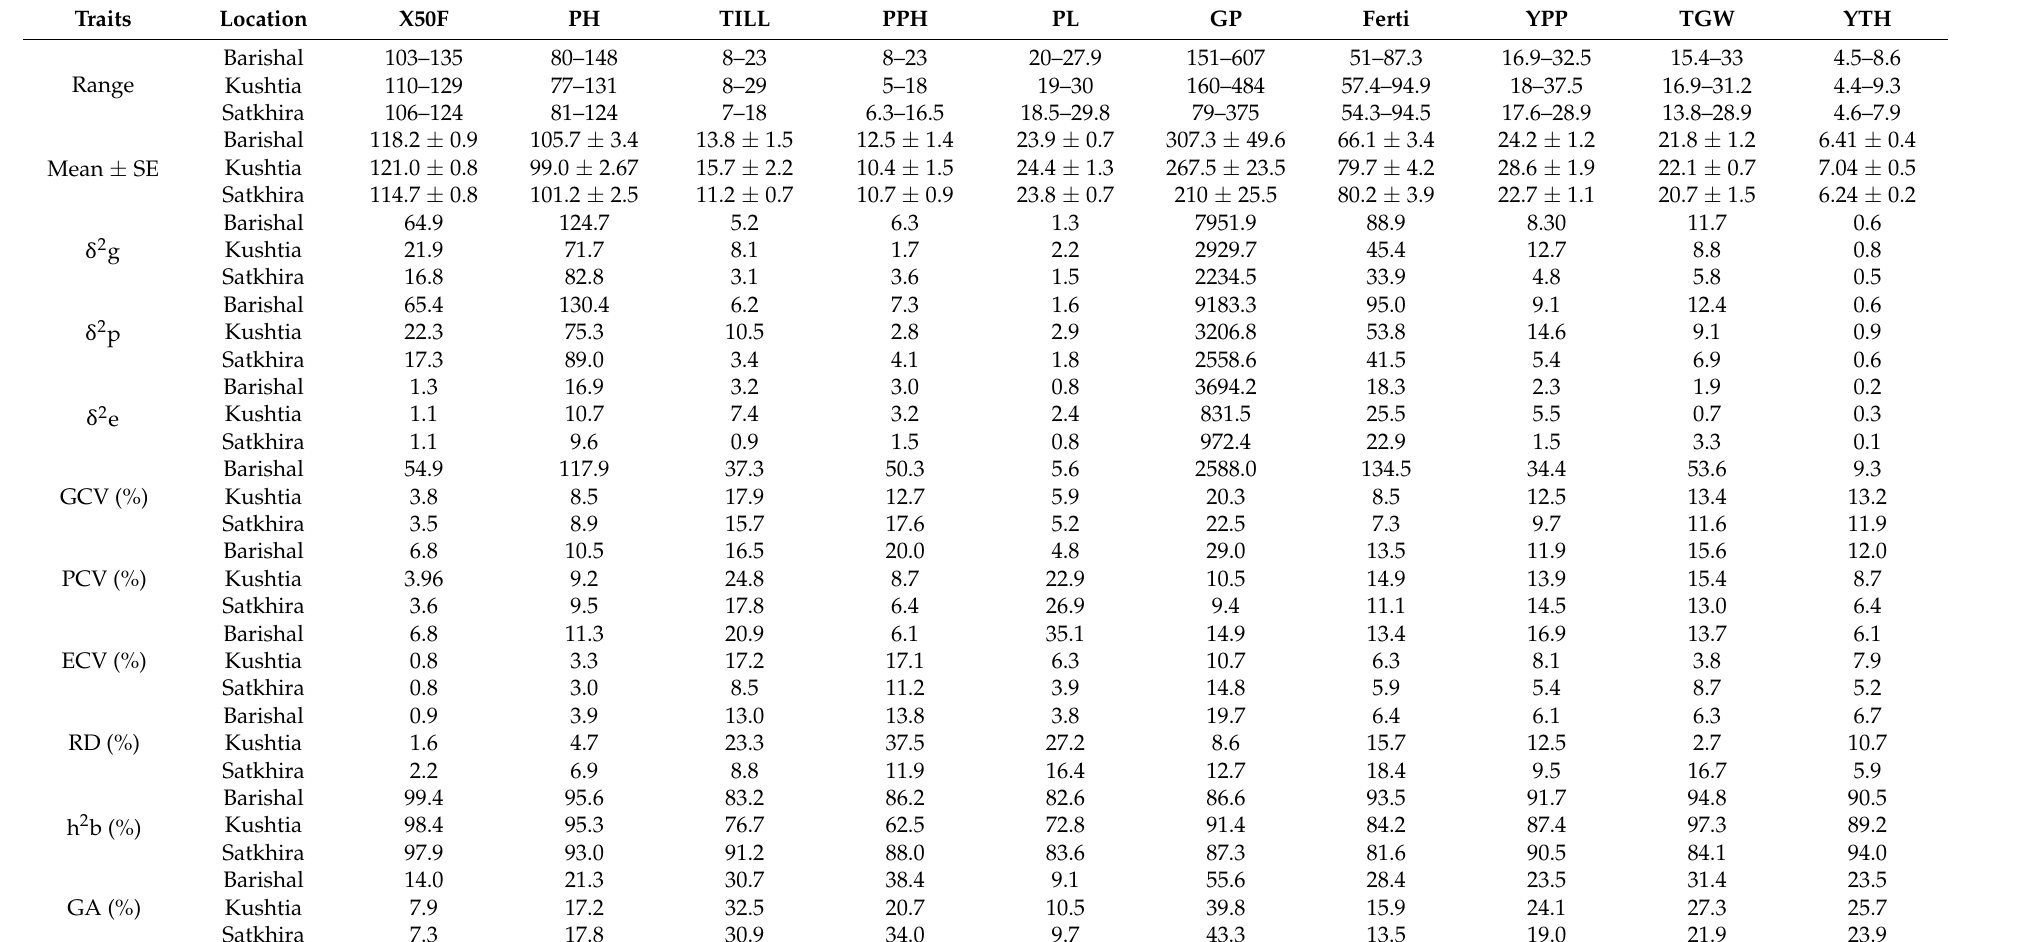
Table 4. Estimation of variance components, broad sense heritability, and genetic advance in elite rice genotypes.